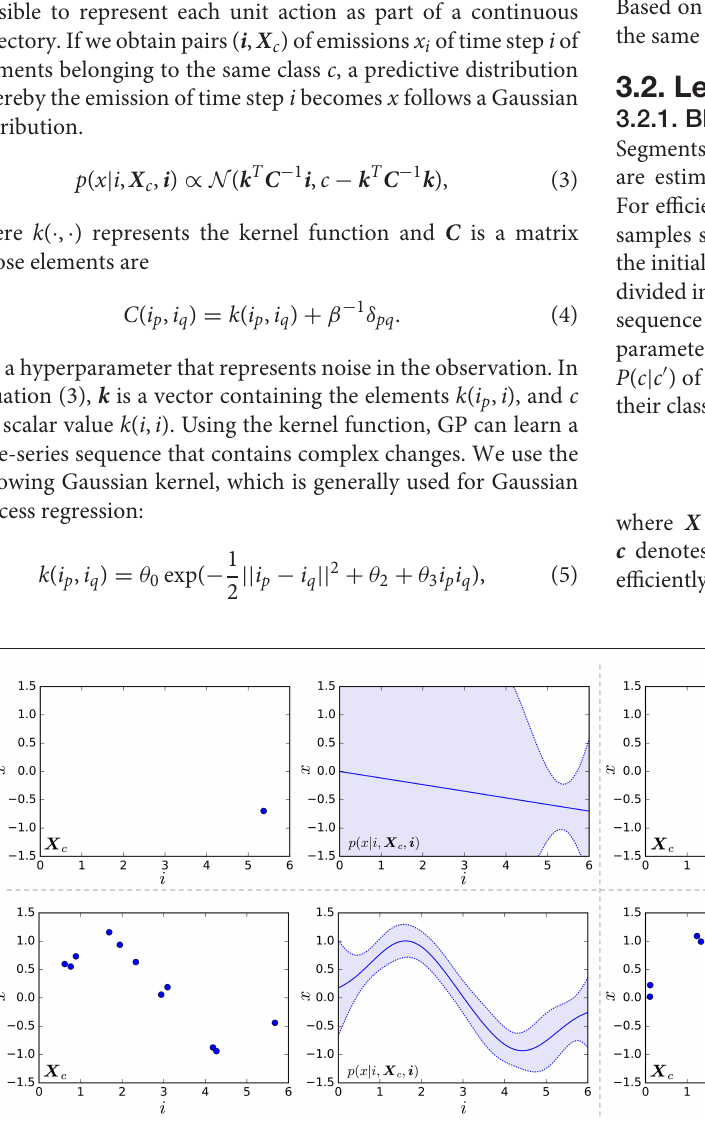
Frontiers in Neurorobotics |